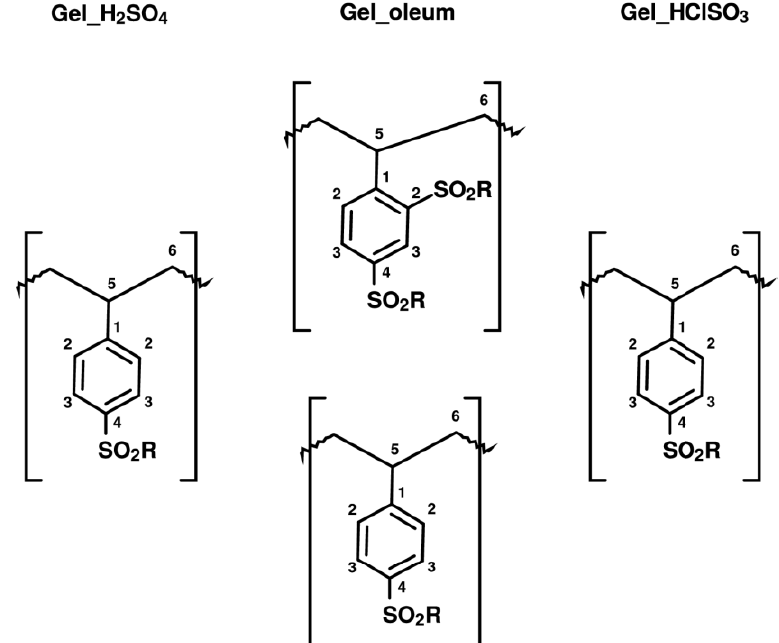
Figure 9. Chemical structures of the samples, expected on the basis of comparison between elemental analysis and ion exchange capacities. The aromatic carbon atoms with similar chemical shifts are labeled with the same letters. The R group is either the − OH moiety (in the case of sulfonic group) or an aromatic ring (in the case of sulfone bridge). Table 5. Integrated intensities (absolute units) of the signals of aromatic carbon atoms.